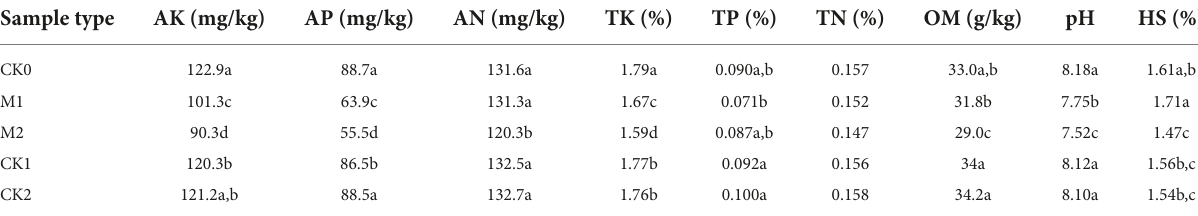
TABLE 2 Effects of continuous cropping of Morchella sextelata on the physicochemical properties of hyphosphere soil. Sample type